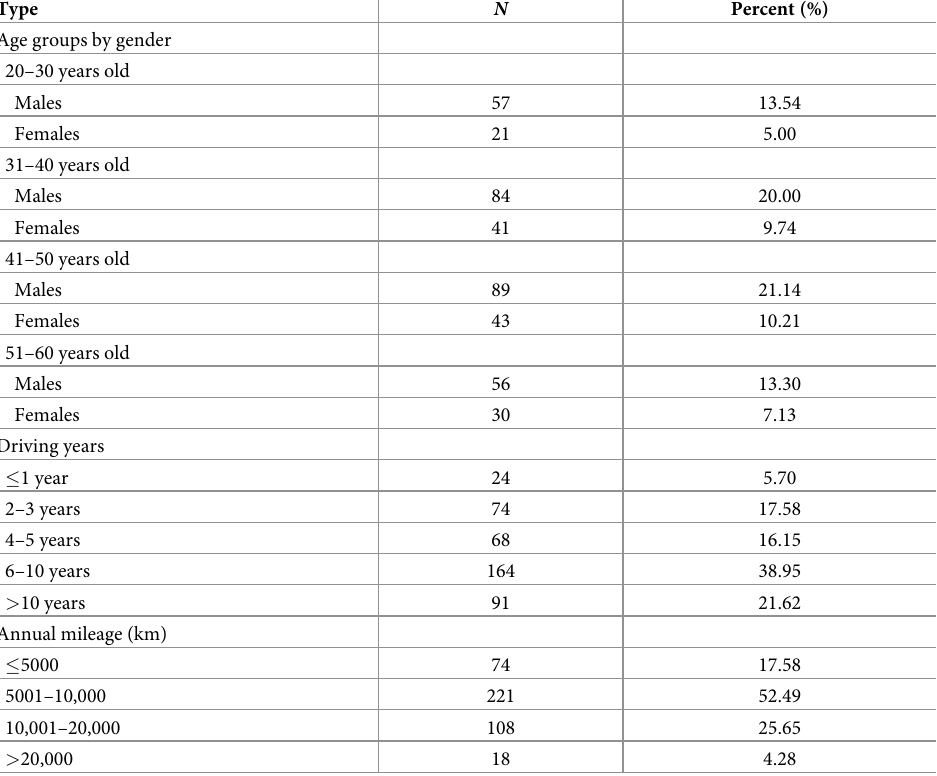
Table 1. Participant demographics ( N =